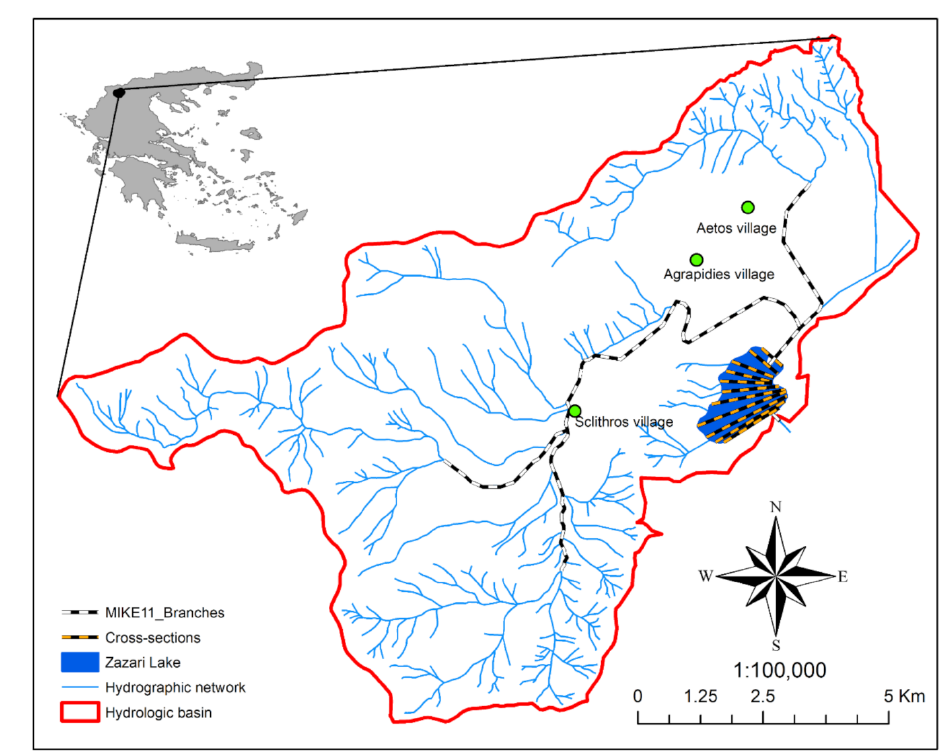
Figure 5. MIKE 11 river network and cross-sections that were included in the hydrological model of Lake Zazari basin.